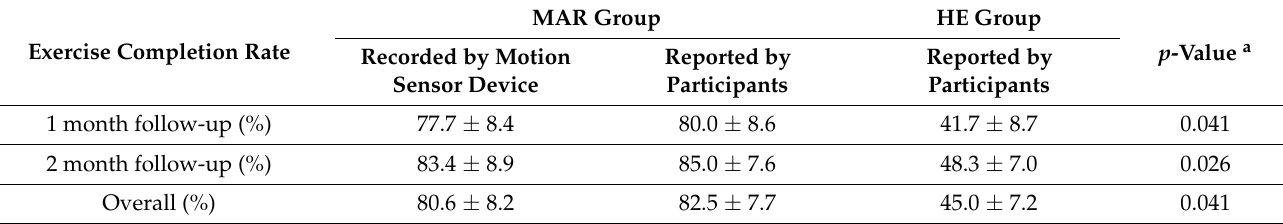
Table 5. Exercise completion rate reported by the participants and MSD.